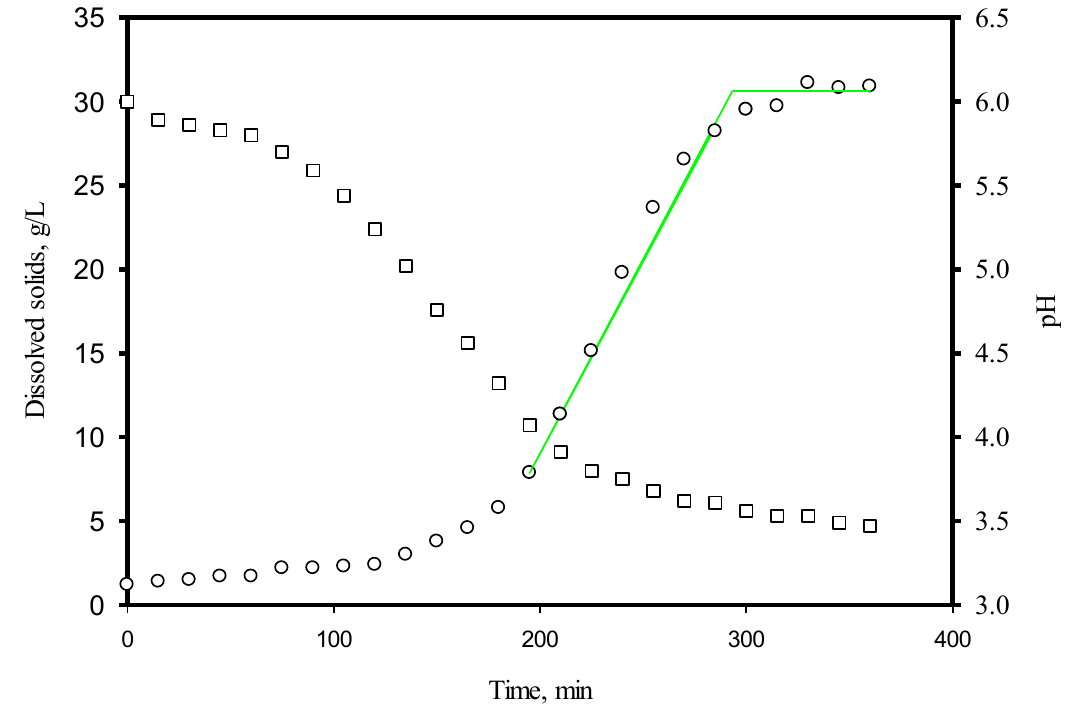
Figure 3. Variations of dissolved solids and pH during hot water extraction of aspen. Square (□) represent pH. Circle (○) represents dissolved solid. The lines are based on Equation (4). The K ED is 288.4 g·min −1